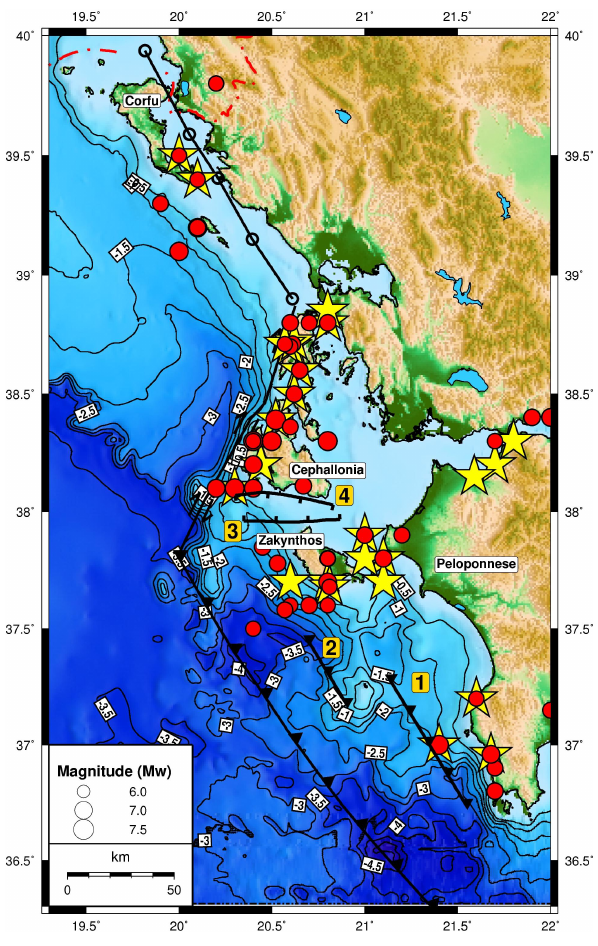
Fig. 1. Earthquakes with M> 6 occurred along the Ionian Sea and the potential tsunamigenic sources (numbers in yellow squares) considered in the present investigation; contour depths are in km. Stars, denote tsunami reported